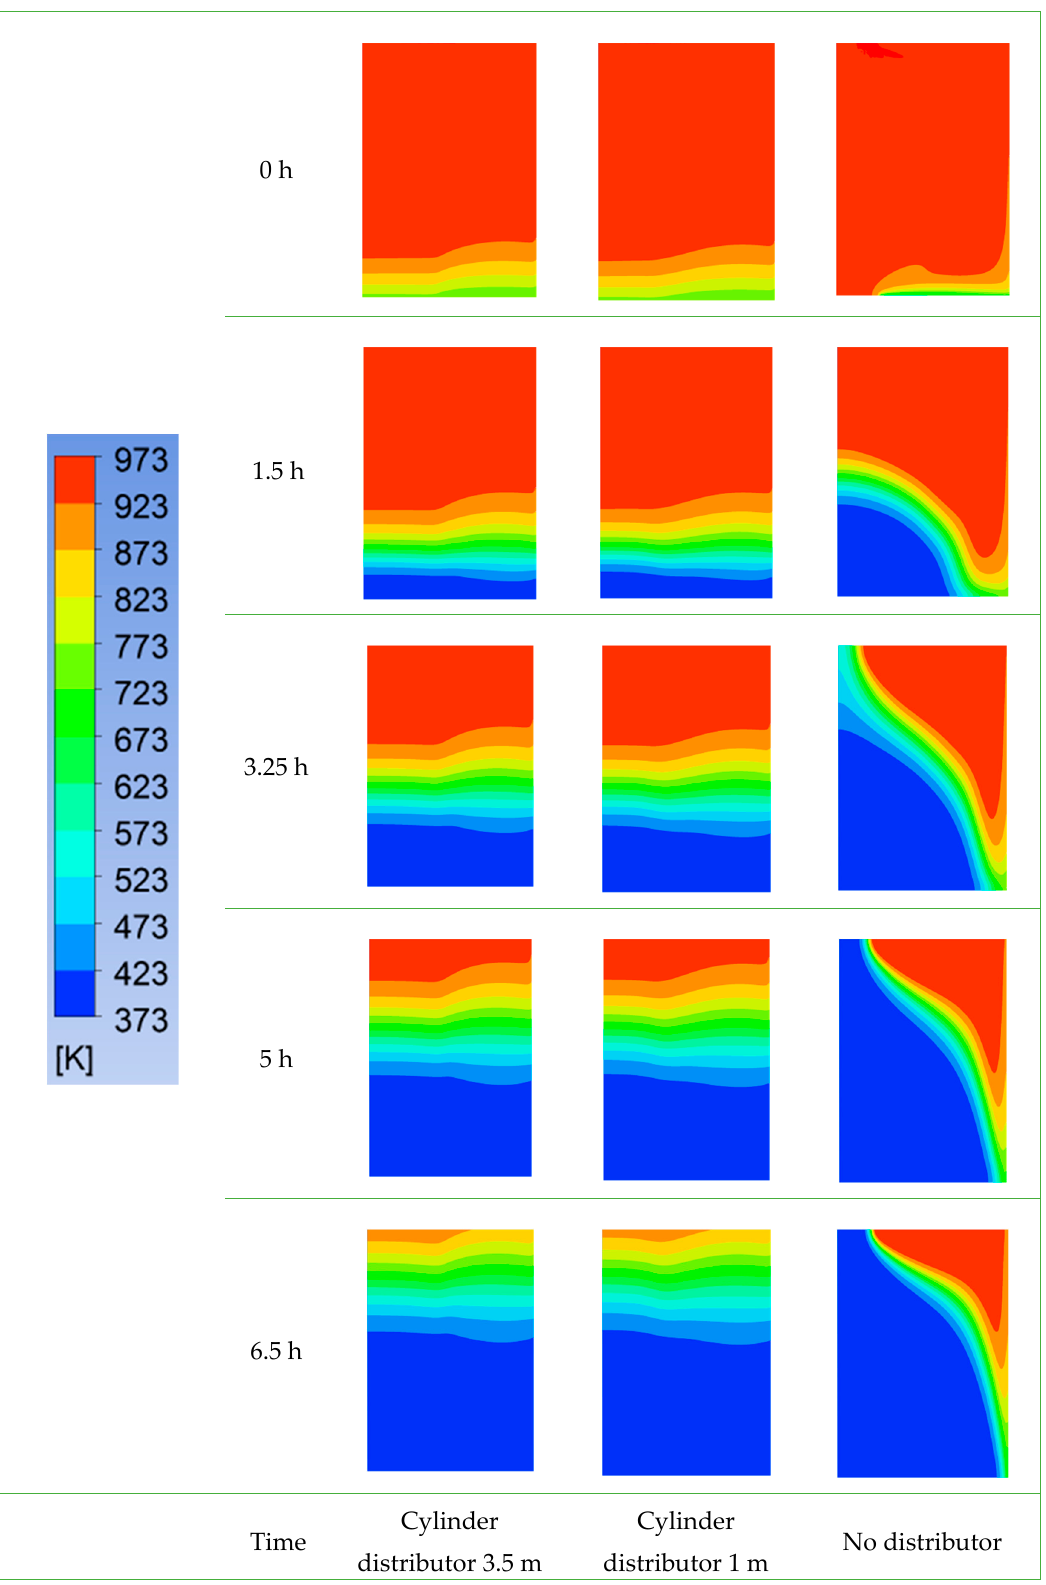
Figure 14. Inventory temperature profiles over storage length and radius after several hours of Figure 14. discharging.